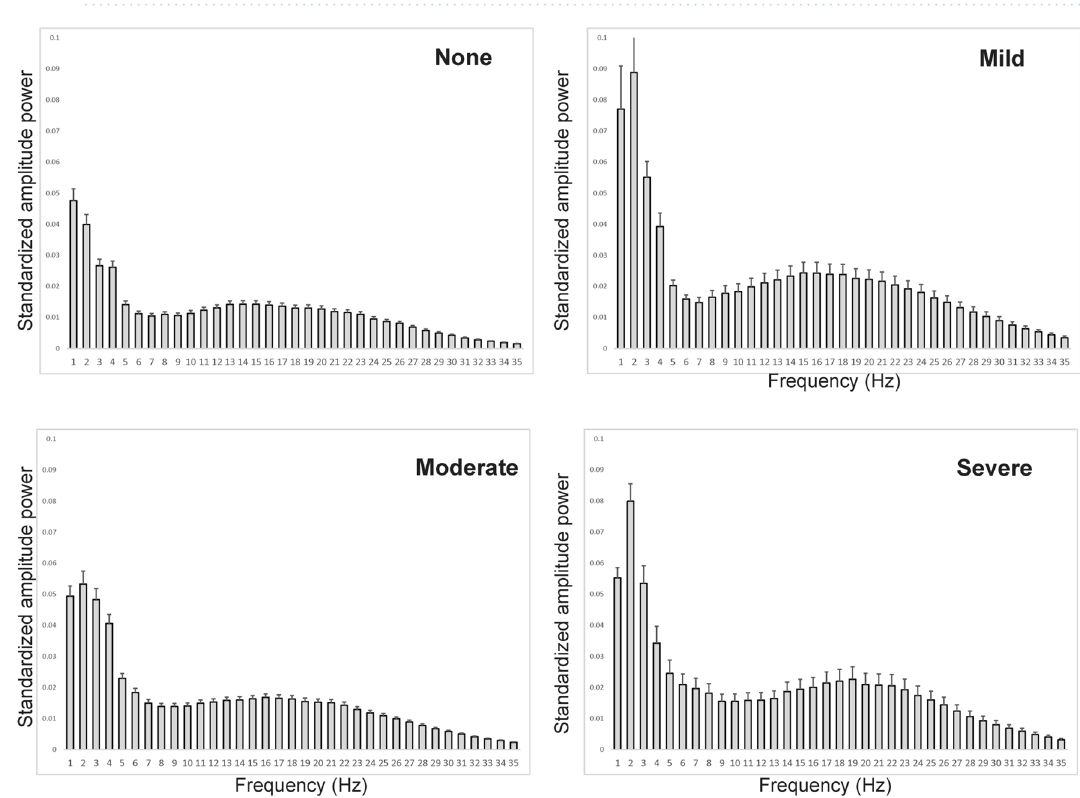
Figure 4. Brain wave amplitude differs significantly among pain levels. Brain wave amplitude was recorded during a five-minute walk in patients with or without hip pain. Each pain level was subdivided into the following quartiles based on the NRS: none (NRS 0, n = 16), mild (NRS 1–3, n = 8), moderate (NRS 4–6, n = 15) and severe (NRS 7–10, n = 7), and the power spectrum at frequencies ranging from 1 to 35 Hz was